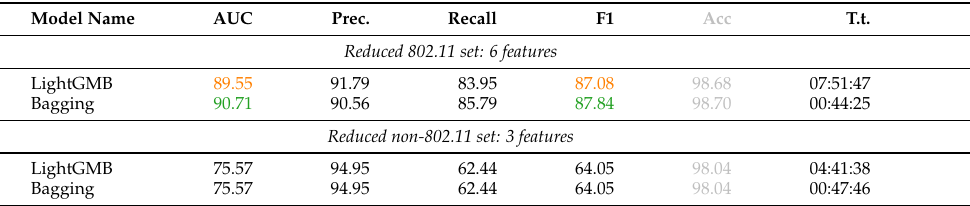
Figure 5. Feature importance through LightGBM for both the feature sets. All the insignificant features for both the feature sets were removed. Table 7. Analysis on the reduced set of features. Best and worse AUC and F1 scores are shown in green or orange text,